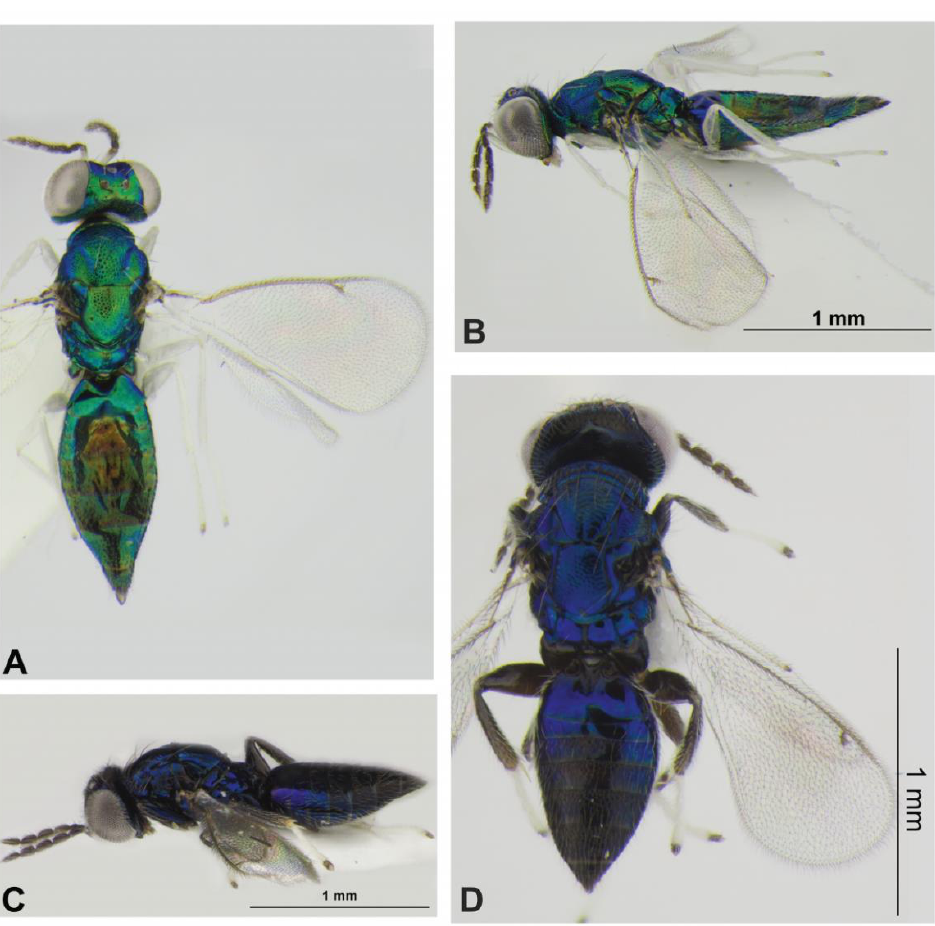
Figure 10. Entedoninae (females): Chrysocharis laomedon (Walker, 1839) ( A , B ) and Pleurotroppopsis japonica (Kamijo, 1977) ( C , D ). Habitus in dorsal view ( A , D ) and lateral view ( B , C ).